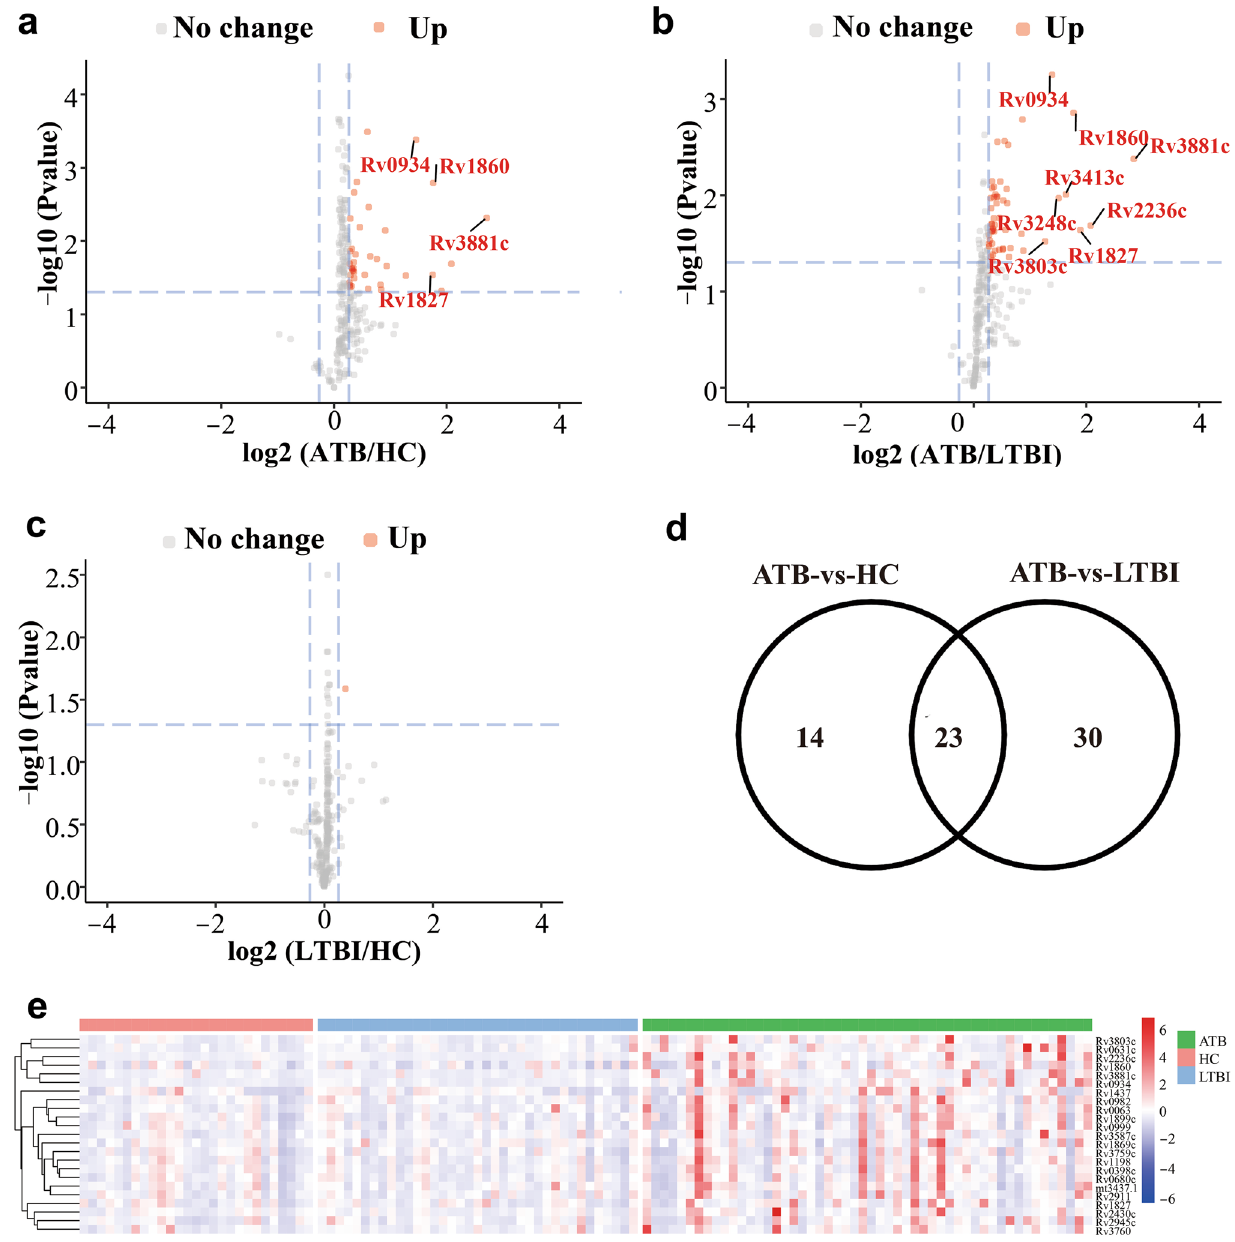
Figure 2. Microarray-based selection of antigens present at different levels in serum samples from individuals with active TB or LTBI or healthy controls. ( a–c ) Volcano plots. Differential analysis of serum samples from the ATB and LTBI groups ( a ), ATB and HC groups ( b ) and the LTBI and HC groups ( c ). Volcano plots show the change in transformed p-value (− log 10 ) against the log 2 ratio in the three groups of serum samples. Blue dashed lines: cut-off values (ratio > 1.2 and p-value < 0.05). Red dots: antigens present at increased levels. Important proteins present at increased levels are labeled. ( d ) Venn diagram. Twenty-three antigens present at higher levels in the ATB group were present in both the ATB-vs-HC and ATB-vs-LTBI comparisons. ( e ) Hierarchical clustering of the 23 differential proteins (from ( d )) in the ATB, LTBI and HC groups. Color bar: signal intensity of the antigen. The heatmap was drawn using the ‘pheatmap’ package (v1.0.12) 23